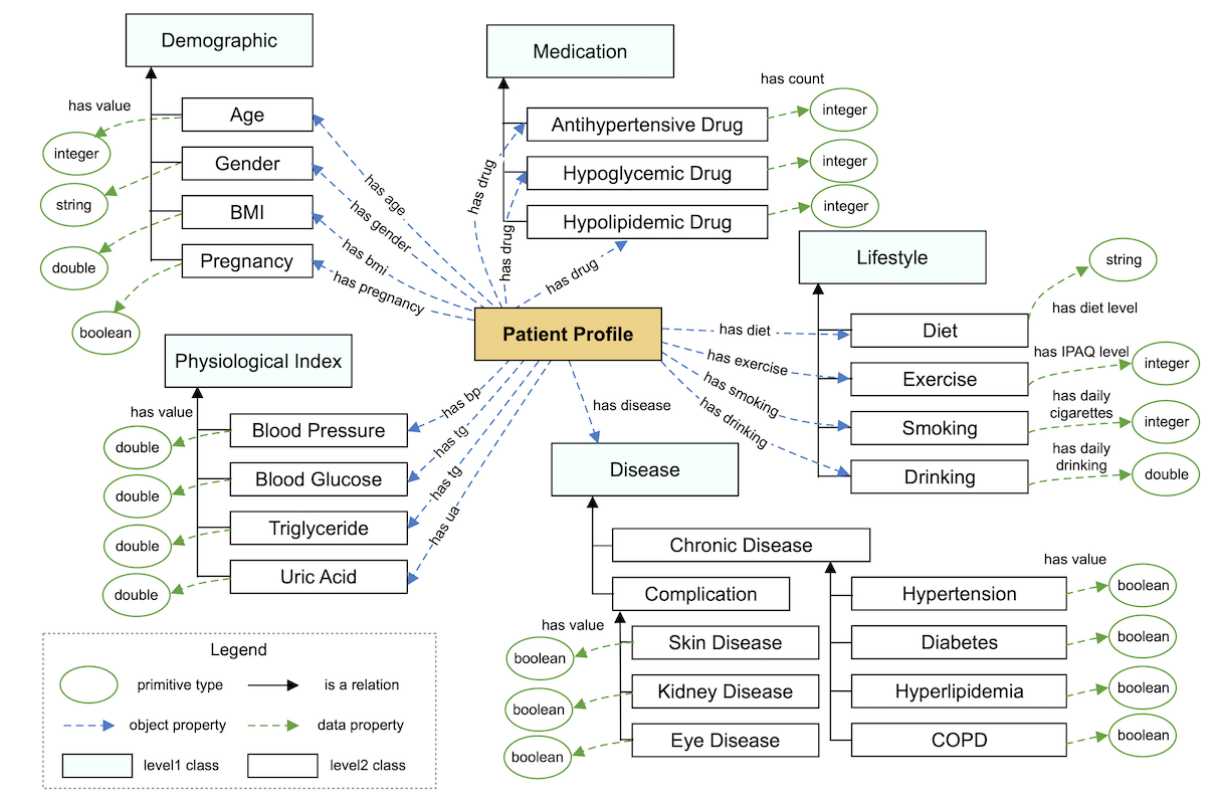
Figure 9. Class diagram of the Chronic Disease Patient Education Ontology’s main